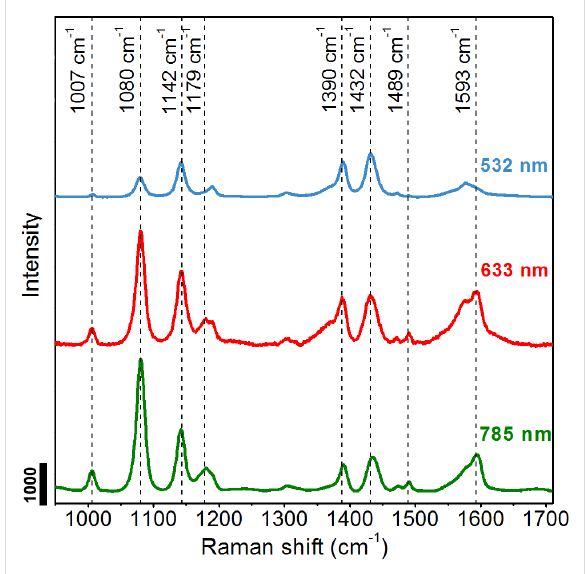
Figure 8: Comparison of the SERS spectra of the pMA monolayer formed on the silver nanoislands film (sample C) recorded using three excitation wavelengths of 532, 633 and 785 nm.